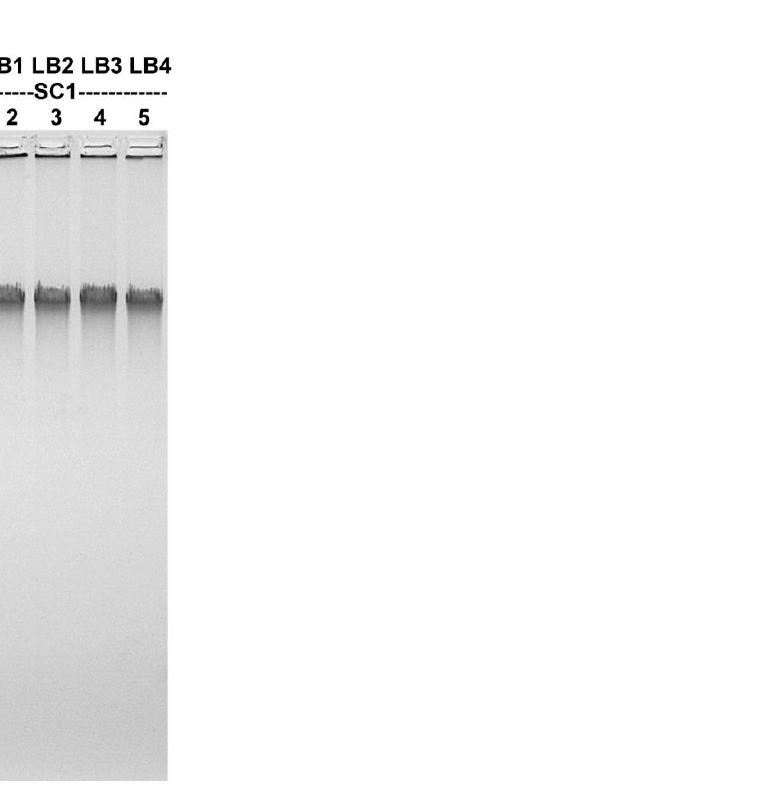
Figure 6. Bacteriophage TP-84 DNA isolated using spin-columns obtained from the Supplier S1 and here developed lysis buffers. Samples were electrophoresed on 1% agarose/TBE gel. Lane M, GeneRuler 1 kb DNA Ladder; lane 1, Supplier S1 buffer; lane 2, lysis buffer LB1; lane 3, lysis buffer LB2; lane 4, lysis buffer LB3; lane 5, lysis buffer LB4.